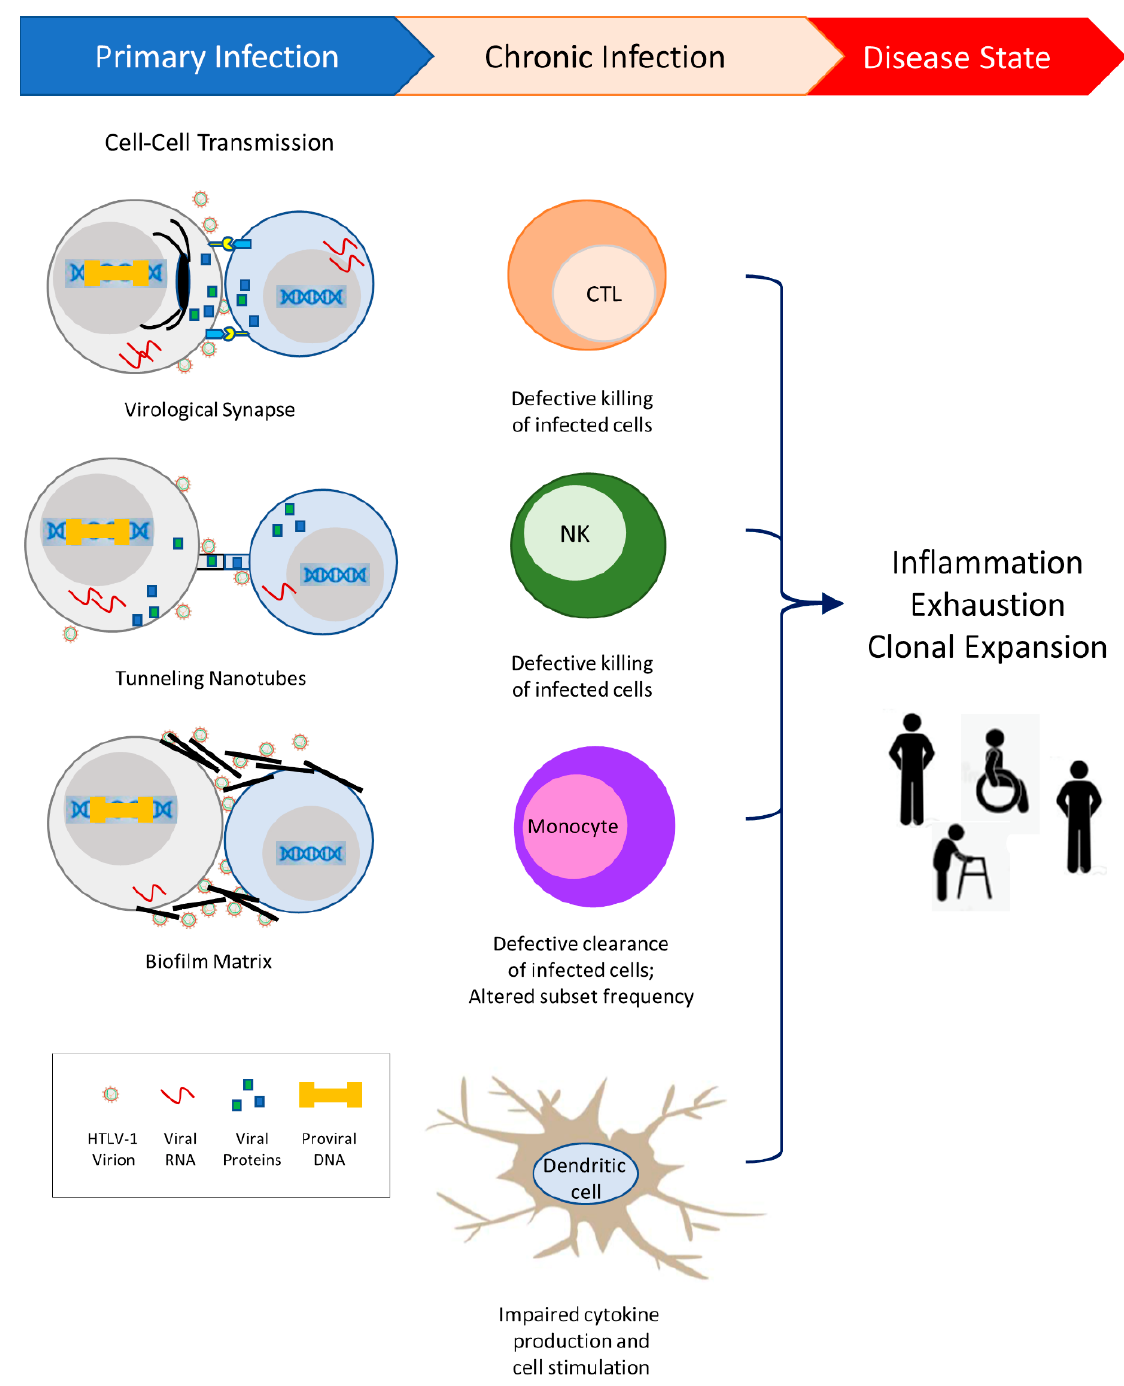
Figure 1. HTLV-1 transmission occurs primarily through cell-to-cell contact. Three modes of trans- mission have been demonstrated: virological synapse, cellular conduits called tunneling nanotubes, and biofilm matrices. HTLV-1 viral proteins enable the evasion of host immunity and contribute to alterations in the innate and adaptive immune responses. Altered responses to chronic HTLV-1 in- fection lead to inflammation and T-cell exhaustion, and allow clonal expansion of infected